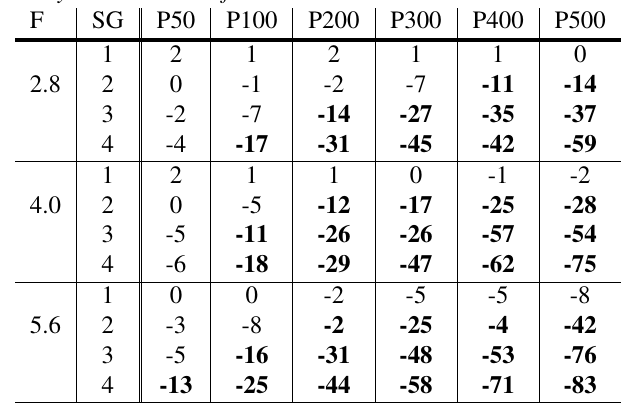
Performance of the ExCuSe algorithm. The results show the reduction in detection rate (in %) due to dirt for an error rate of 5 pixels. The baseline are detection rates achieved on clean images. F represents the focal length, SG the size group, whereas P50-P500 values specify the amount of par- ticles. Bold highlights a reduction in the detection rate rela- tively to clean data of more than 10%.